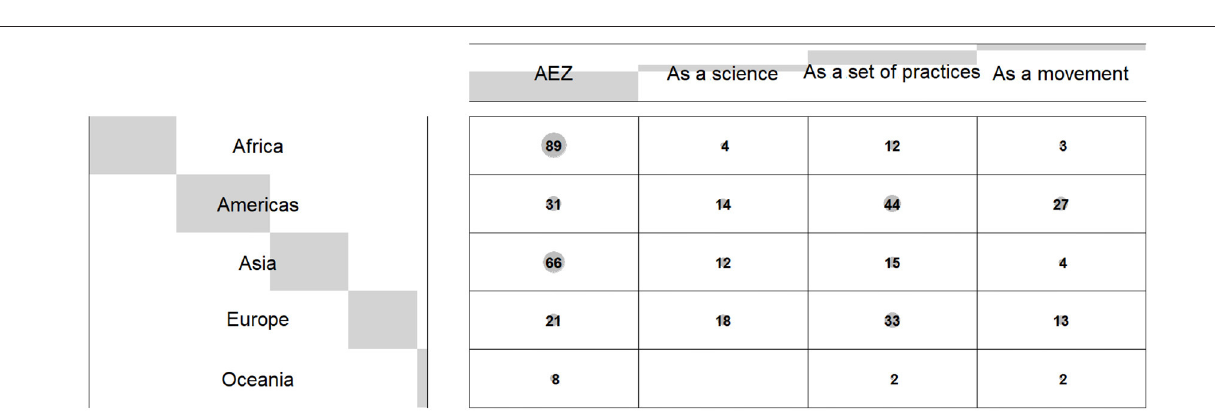
FIGURE 3 | Distribution of case studies according to the agroecological type and continental location. In the column heading, the gray bar represents the frequency of case studies on the continents. In the row label, the gray bar represents the frequency of case studies referring to agroecological type. Circles are proportional to the frequency of